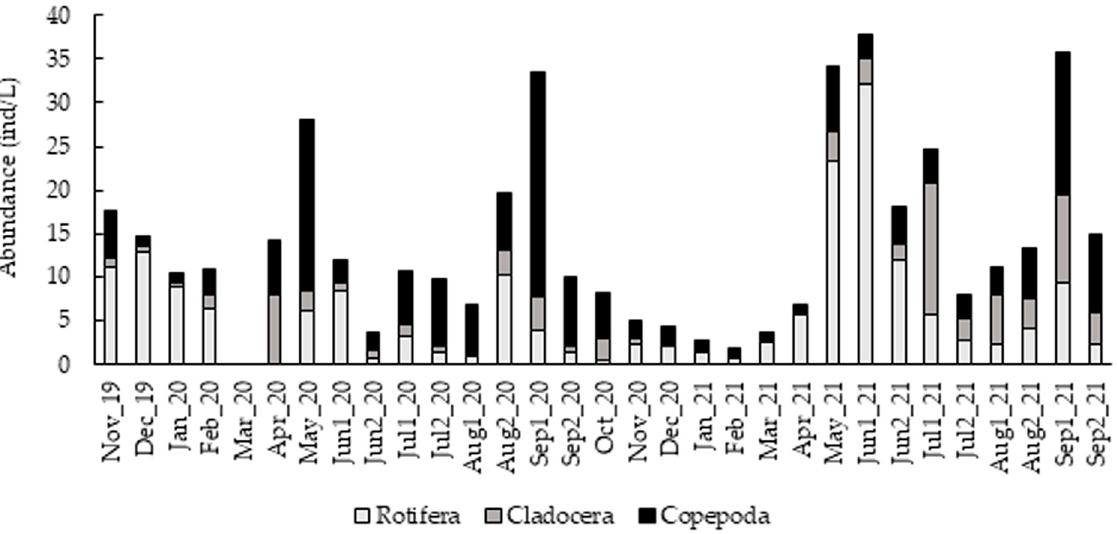
Figure 5. Total zooplankton abundance (ind/L) in the Moglicë Reservoir during November 2019– September 2021.